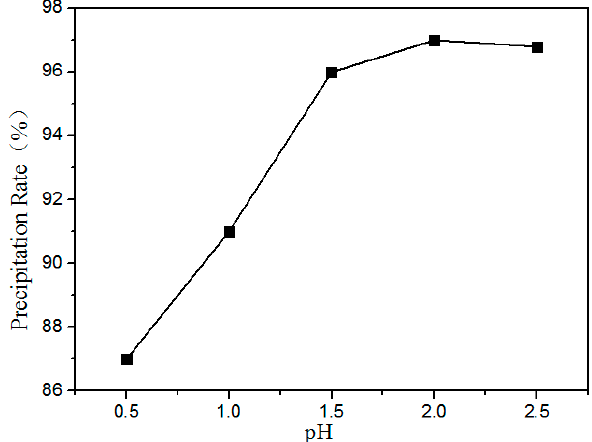
Figure 12. Effect of pH value on the precipitation ratios of RE elements.